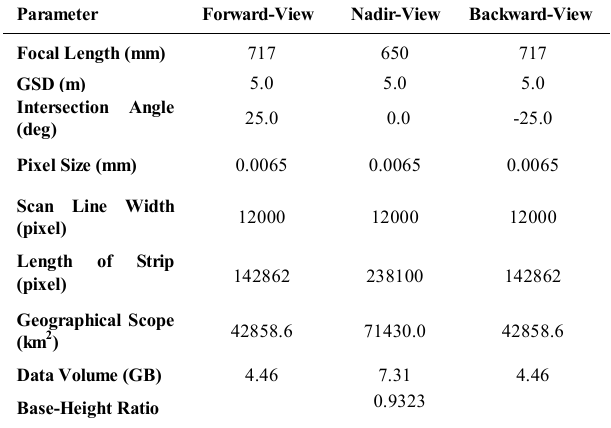
Table 1. Camera parametres of the three linear array sensor for Chinese Mapping Satellite